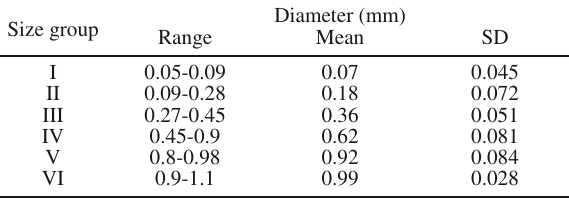
Table 3. – Diameter of size groups of oocytes from the ovary.